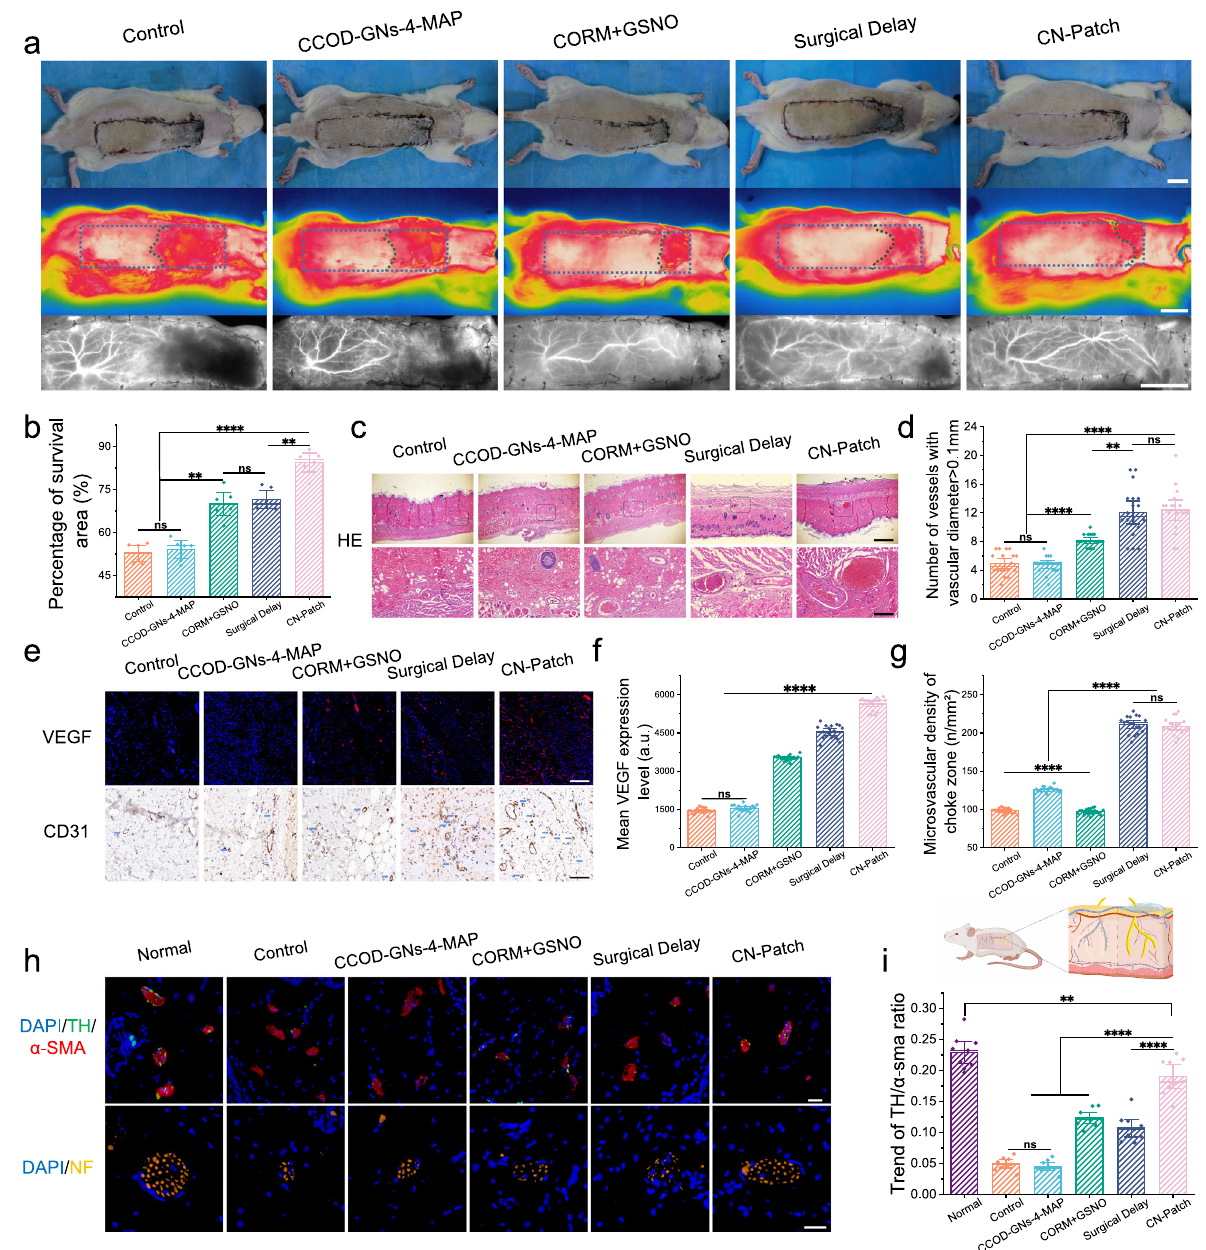
Fig. 4 | Survival status of fl aps after treatment. a The fi rst row of general observation,thesecondrowofdigitalinfraredthermalimages,andthethirdrowof NIR-II angiography show the survival rates of skin fl aps on the seventh day after surgery. Scale bar: 2cm. b The percentage of fl ap survival areas in each group on the postoperative seventh day (mean±SEM, n =6 animals per group). c First row, H&Estainingof fl apchokezones,blackrectanglesindicatedilatedvessel.Scalebar: 200 µ m. Second row, higher magni fi cation of the images above. Scale bar: 50 µ m. d Theaveragenumberofvesselswithadiametergreaterthan0.1mmineachgroup (mean±SEM, n =6animalspergroup). e DistributionofVEGF(upperrow,red)and CD31 (lower row) expression of choke zones on 7 d postoperative based on immuno fl uorescenceand immunohistochemistrystaining results. The blue arrows